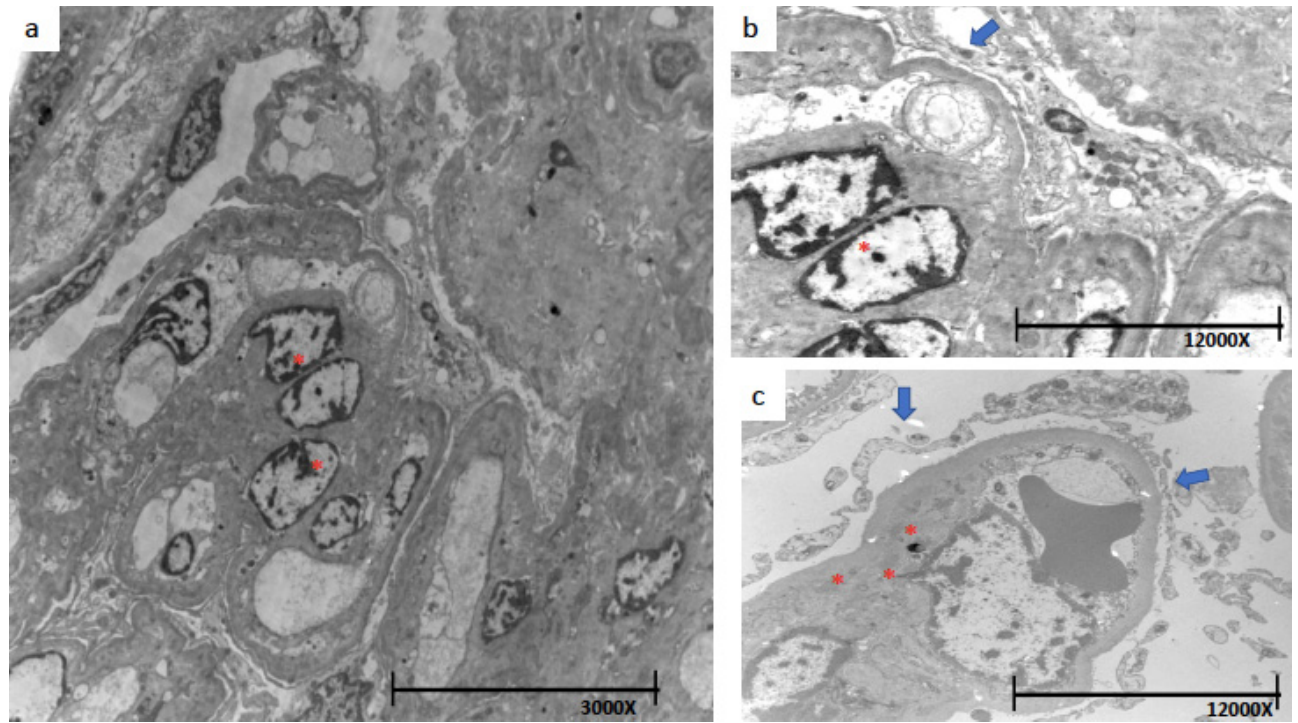
Figure 5. ( a ) 3000× Electron microscopy shows mesangial hypercellularity *, ( b , c ) 12,000× electron microscopy. Shown in b, mesangial hypercellularity * and effacement of podocyte processes (ar- row), ( c ) There is accentuated damage to podocyte processes (arrow) with deposits of electron dense